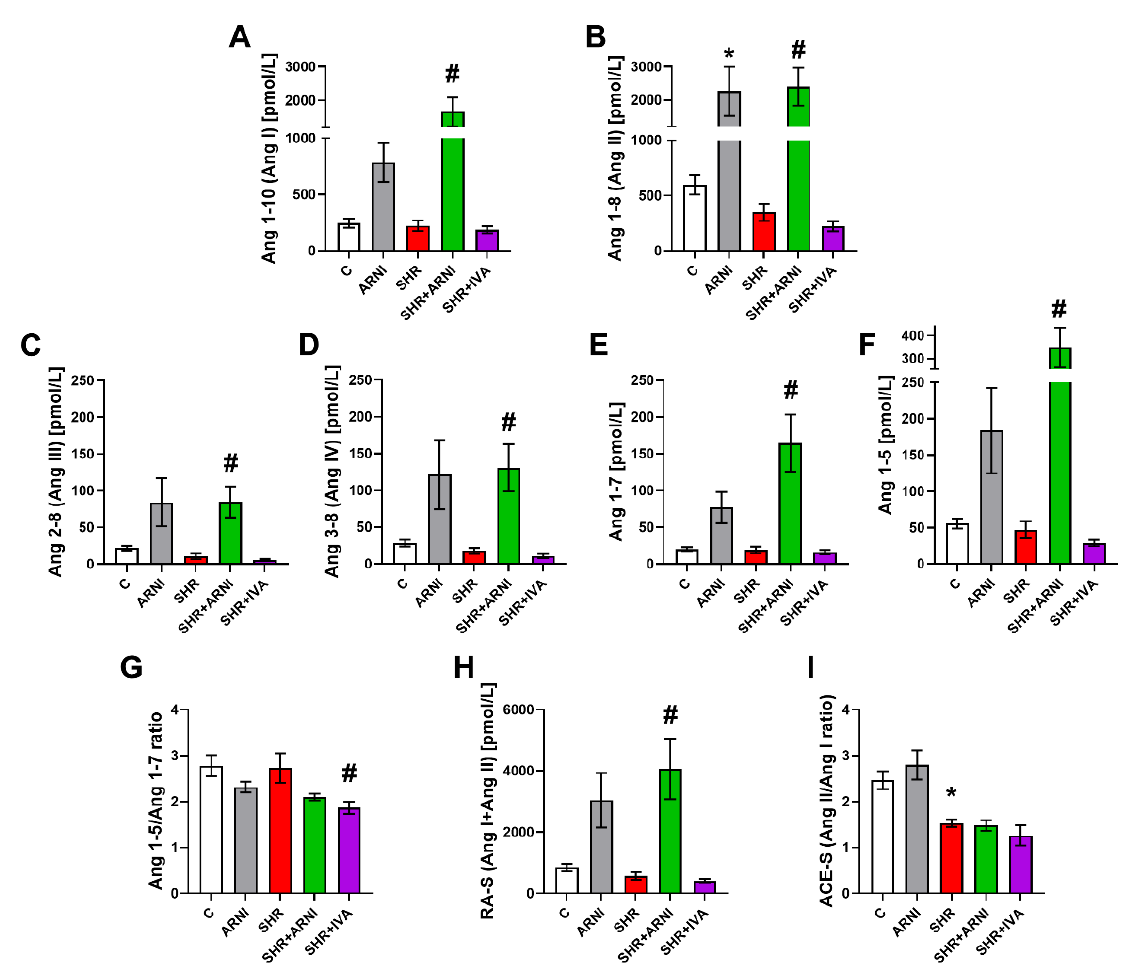
Figure 4. Effect of ARNI and ivabradine on the serum level of angiotensin 1-10 (Ang I) ( A ), angiotensin 1-8 (Ang II) ( B ), angiotensin 2-8 (Ang III) ( C ), angiotensin 3-8 (Ang IV) ( D ), angiotensin 1-7 ( E ), angiotensin 1-5 ( F ), angiotensin 1-5/angiotensin 1-7 ratio ( G ), marker of renin activity (RA-S; Ang I + Ang II) ( H ), and marker of angiotensin-converting enzyme activity (ACE-S; Ang II/Ang I) ( I ) in SHRs after six weeks of treatment. Ang, angiotensin; ARNI, sacubitril/valsartan; C, Wistar controls; IVA, ivabradine; SHRs, spontaneously hypertensive rats. Results are presented as means ± SEM. n = 6 per group. One-way, two-tailed ANOVA followed by multiple comparisons with a Bonferroni post-hoc test; * p < 0.05 vs. C; # p < 0.05 vs. SHR. The serum concentration of aldosterone was 312.73 ± 66.99 fmol/mL and 163.63 ± 29.02 fmol/mL in the control and SHR groups, respectively (ns); ARNI increased it by 10% (ns) and 203% ( p < 0.05) in the control and SHR groups, respectively (Figure 5A). The aldosterone/Ang II ratio (AA2 ratio) was 0.55 ± 0.14 and 0.52 ± 0.08 in the control and SHR groups, respectively (ns); ARNI decreased it by 61% (ns) and 52% (ns) in the control and SHR groups, respectively (Figure 5B). Ivabradine had no effect on the serum concentration of aldosterone and the AA2 ratio in SHRs after six weeks of treatment (Figure